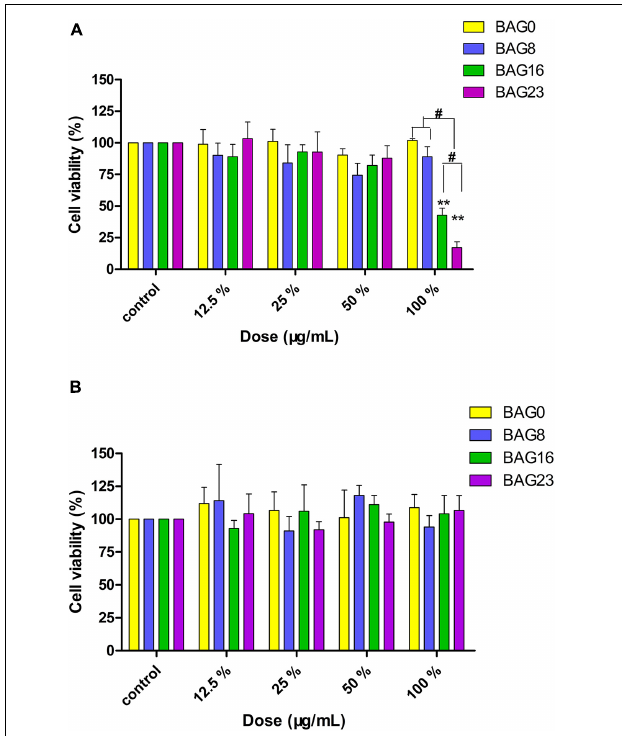
FIGURE 4 | Cytotoxicity determined by MTT assay. (A) Cytotoxic effects of the extracts of BAG-modified composite resins after 24-h exposure. (B) Effects of pH adjustment of the extracts on cell viability. Results are presented in mean ± SEM of three independent experiments. ** p < 0.01 vs. control. # p < 0.05 significant difference as compared groups. BAG0: the extracts of the composite resin without BAG; BAG8: the extracts of the composite resin with 8 wt% BAG; BAG16: the extracts of the composite resin with 16 wt% BAG; BAG23: the extracts of the composite resin with 23 wt% BAG.